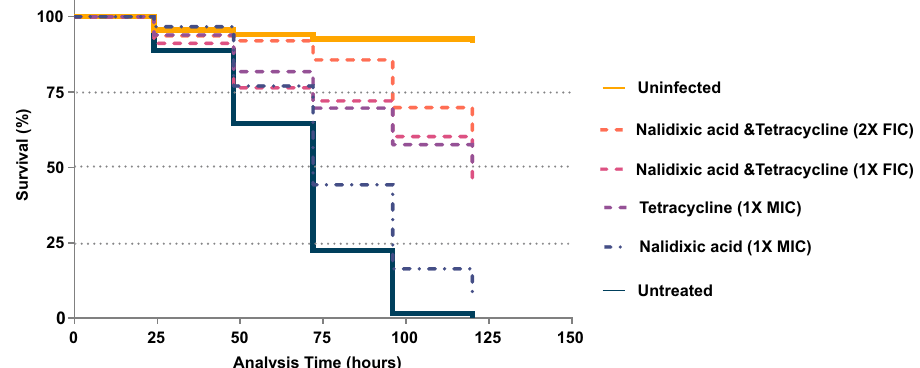
Fig. 7 In vivo ef fi cacy of nalidixic acid and tetracycline combination in C. elegans . Kaplan – Meier survival curve displaying synergy of nalidixic acid and tetracycline in the C. elegans – A. baumannii liquid infection model. Larvae ( n ~ 60) were infected by A. baumannii AB5075-UW (a highly virulent MDR isolate) and treated with single antibiotics (nalidixic acid, tetracycline alone at 512 and 0.5 mg/L, respectively) or with a combination of antibiotics (1× FIC — nalidixic acid, tetracycline at 128 and 0.125 mg/L, respectively, or 2× FIC — nalidixic acid, tetracycline at 256 and 0.25 mg/L, respectively). One group was left untreated. The uninfected group was kept without bacterial infection and act as a negative control. The percentage of surviving larvae was monitored at indicated intervals after infection. Combination of nalidixic acid and tetracycline signi fi cantly prolonged larval survival; p < 0.001; log-rank (Mantel – Cox) does not depend on PMF and ROS directly, although these two bactericidal (enro fl oxacin) and bacteriostatic (tigecycline) antibiotic factors may contribute signi fi cantly for any given synergy 17,26 . against tetracycline-resistant E. coli , although the study did not focus on the mechanism of synergy 25 . Reduced PMF, in turn, impairs the function of multidrug ef fl ux Our study has highlighted some key fi ndings of nalidixic acid pumps that use PMF to export antibiotics from the cell, causing and tetracycline synergy against A. baumannii AYE. We found increased sensitivity to antibiotics 27 . In our study also, we that the synergistic combination of nalidixic acid and tetracycline observed a decrease in MIC of nalidixic acid and tetracycline in A.